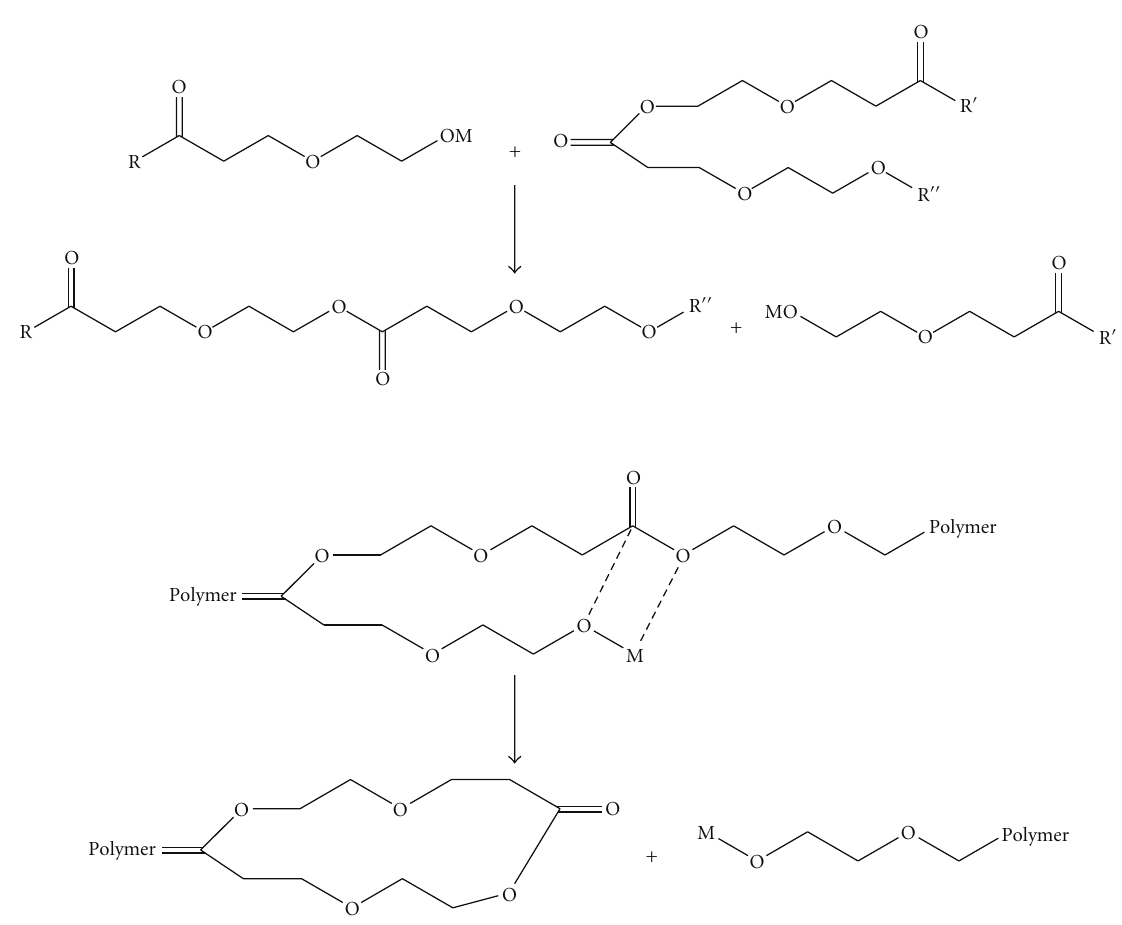
Scheme 10: Intra- and intermolecular transesterificiation reactions during ring opening